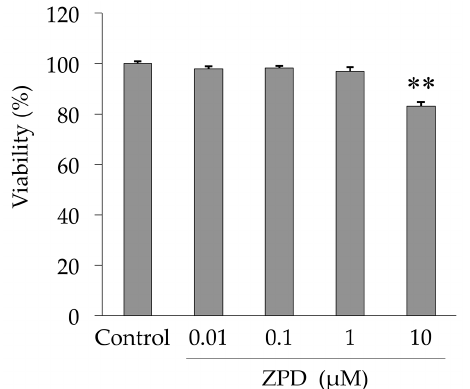
Figure 1. Influence of ziprasidone (ZPD) on viability of PC12 cells. The cells were treated with ZPD for 24 h. Cell viability was determined using CellTiter-Blue assay, and the results are expressed as percentage of the Control value. Experiments were repeated at least three times, and the values represent the mean of three experiments ± standard deviation (SD). ** p < 0.01 versus